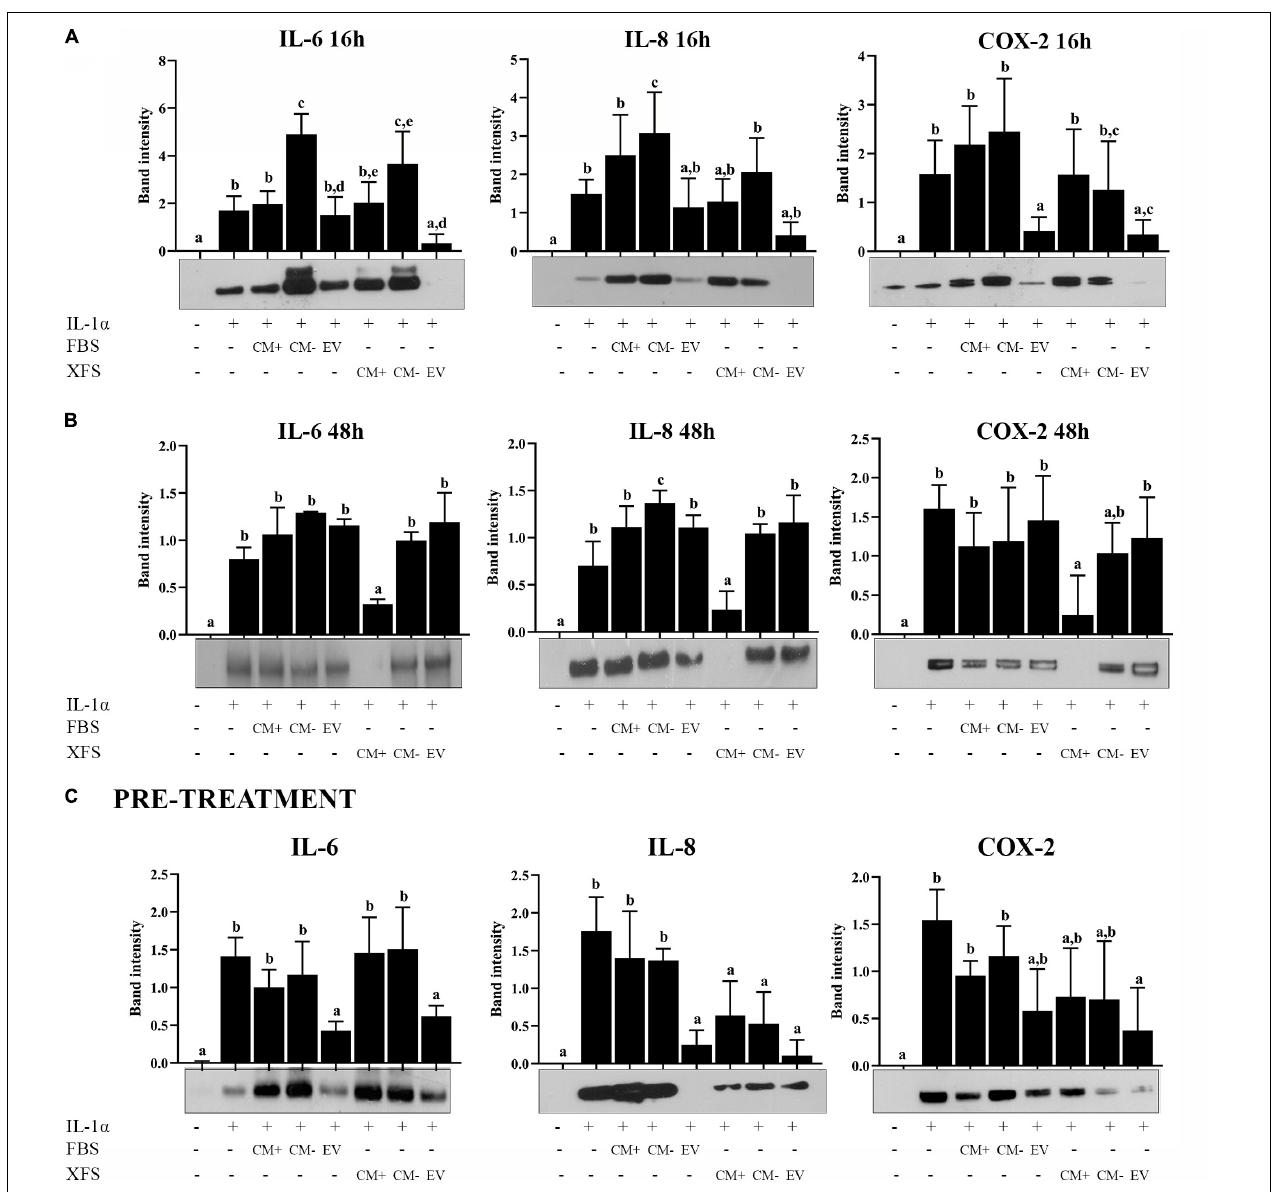
FIGURE 8 | Response of OA-hACs to treatment with EVs. (A) Response of OA-hACs to 16 h hBMSC-EVs treatment in an inflammatory microenvironment with IL-1 α . Western blot analysis of secreted IL-6 and IL-8 and COX-2 cellular content was performed, and the corresponding band intensity was determined by densitometric analysis. The intensity values were normalized to tubulin protein expression. Data are shown as mean ± SD of at least five independent experiments. Values with shared letters are not significantly different ( P > 0.05) according with two-way ANOVA followed by Tukey as post hoc test. (B) Response of OA-hACs to 48 h hBMSC-EVs treatment in an inflammatory microenvironment with IL-1 α . Data are shown as mean ± SD of at least five independent experiments. Values with shared letters are not significantly different ( P > 0.05) according with two-way ANOVA followed by Tukey as post hoc test. (C) Response of hACs after 3 h pre-treatment with hBMSC-EVs and subsequent inflammatory induction with IL-1 α for 16 h. Western blot analysis of secreted IL-6 and IL-8 and COX-2 cellular content. The intensity values were normalized to tubulin protein expression. Data are shown as mean ± SD of at least five independent experiments. Values with shared letters are not significantly different ( P > 0.05) according with two-way ANOVA followed by Tukey as post hoc